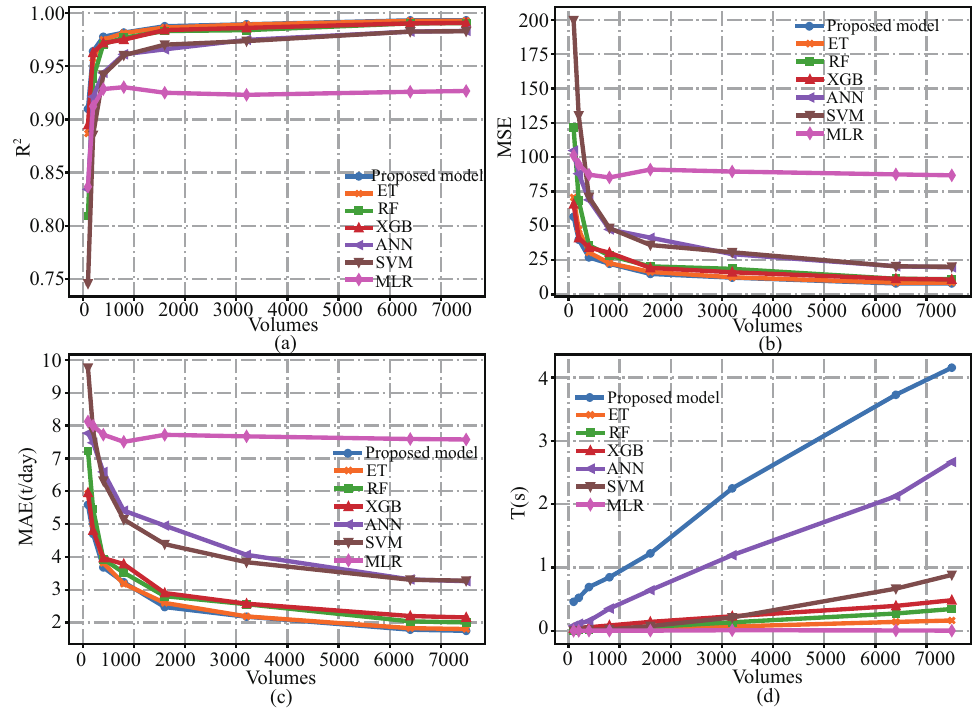
Figure 5. The impact of different data volumes on the model: ( a ) R 2 . ( b ) MSE. ( c ) MAE. ( d )